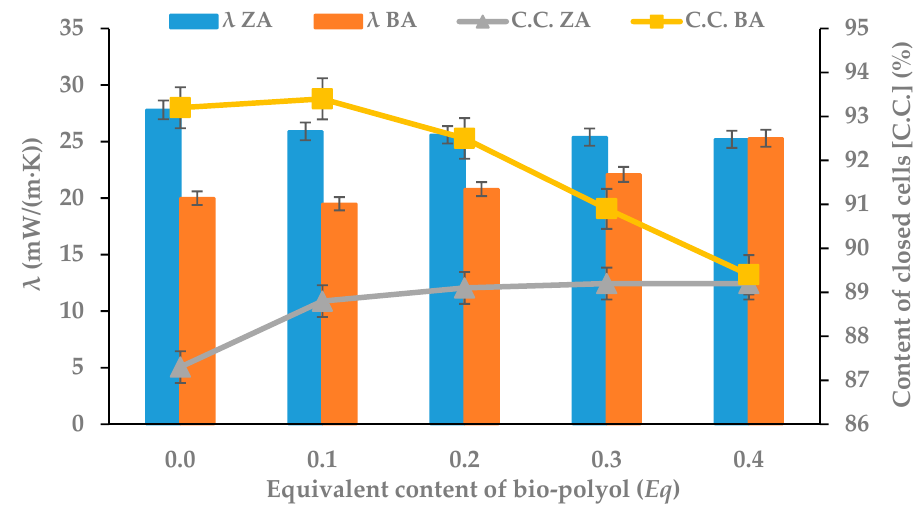
Figure 6. Dependence between bio-polyol content, thermal conductivity coefficient λ and content of closed cells (C.C.).